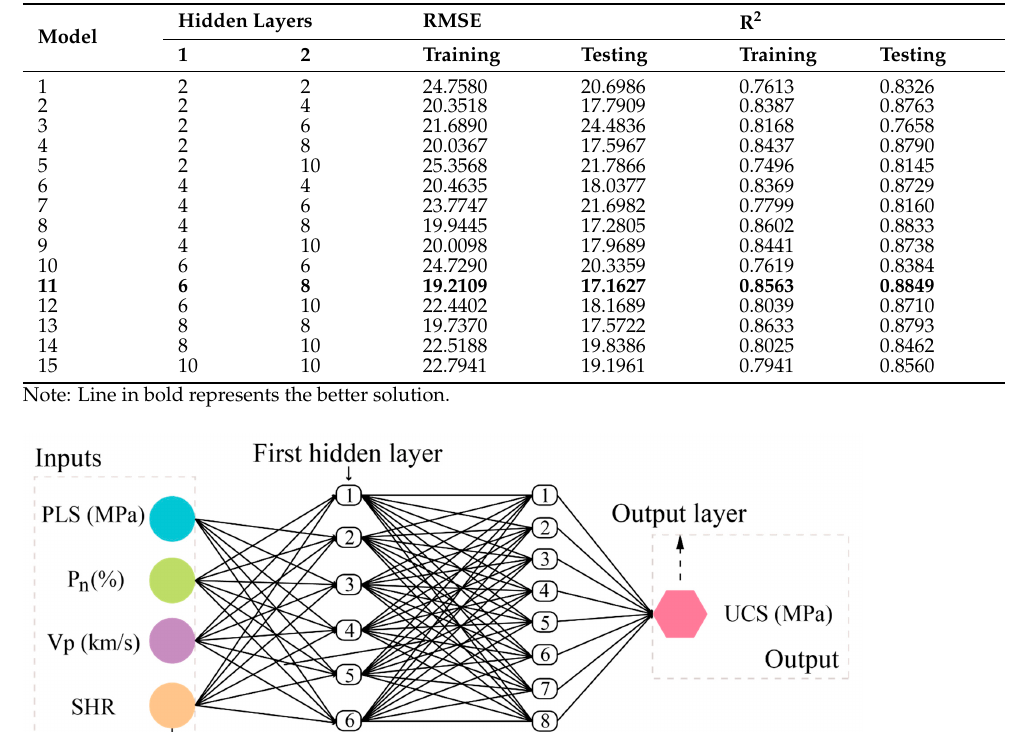
Table 4. Performance evaluation of BPNN with various neurons of two hidden layers.